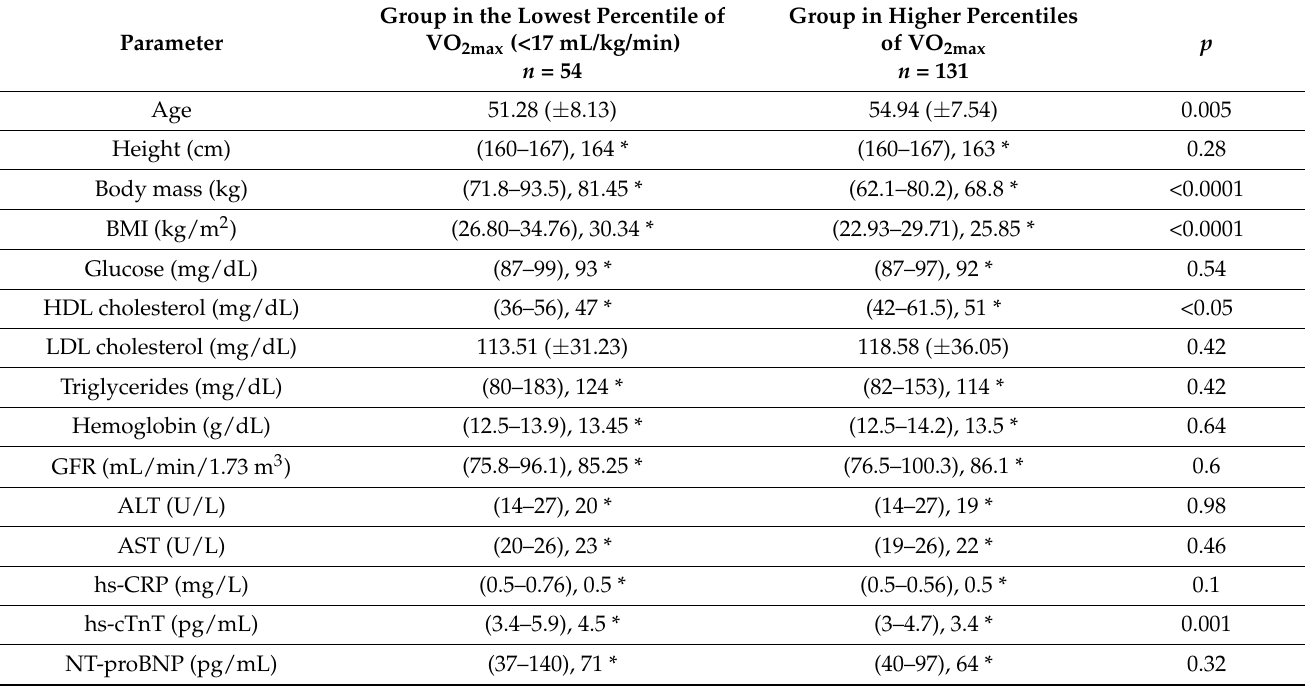
Table 1. Evaluation of basic